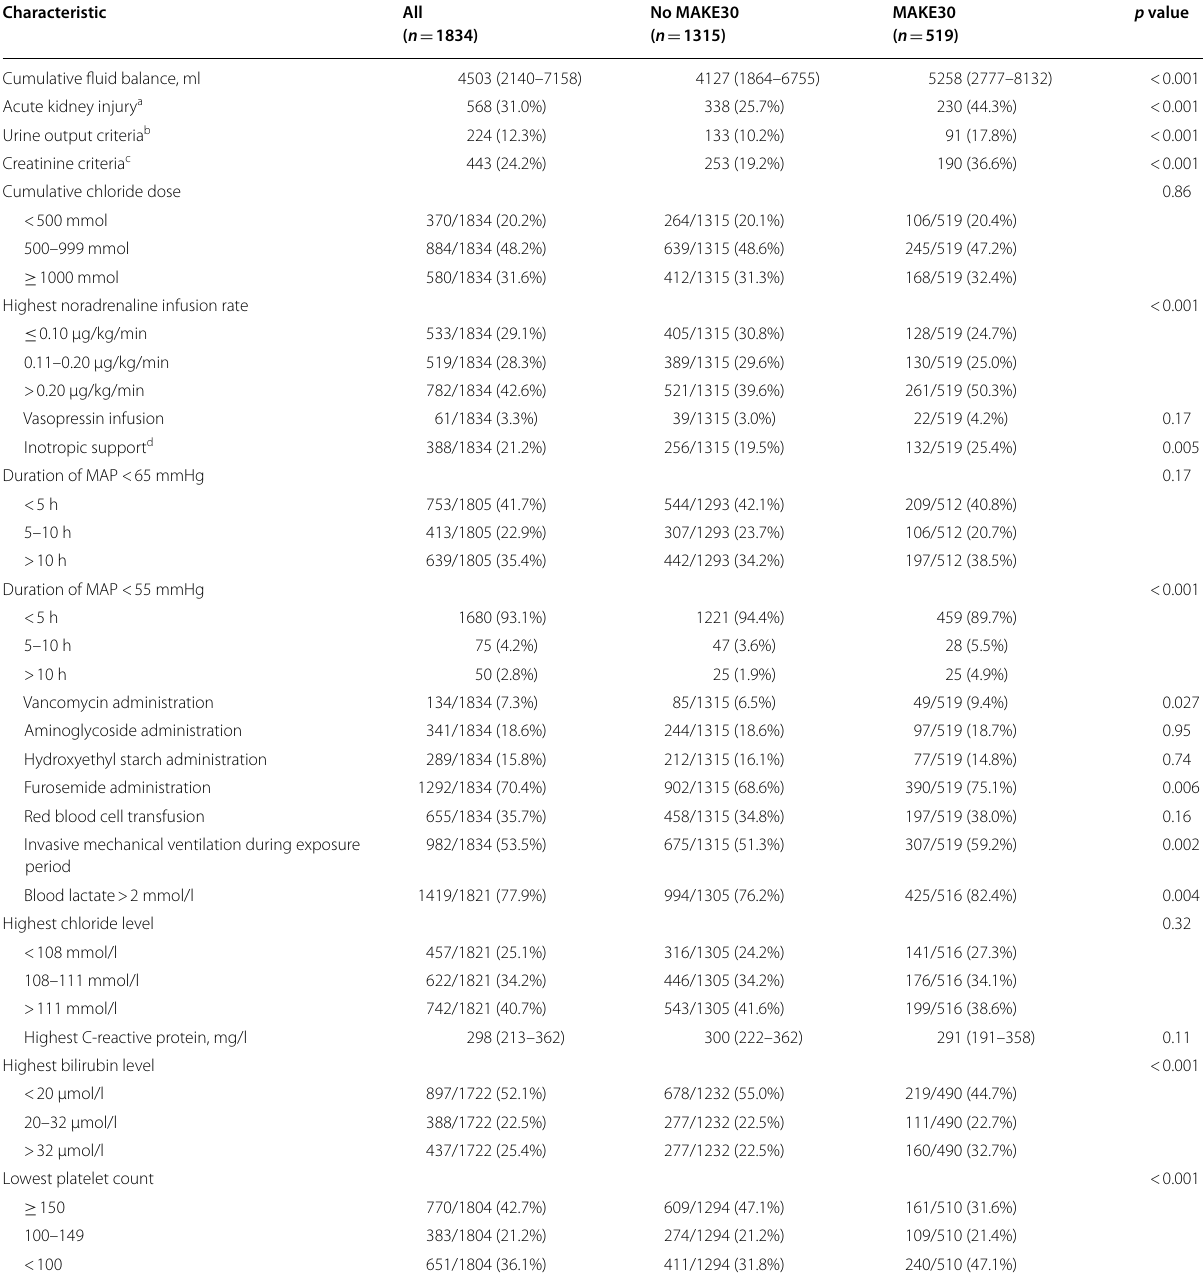
Table 3 Process of care and biochemical characteristics during exposure